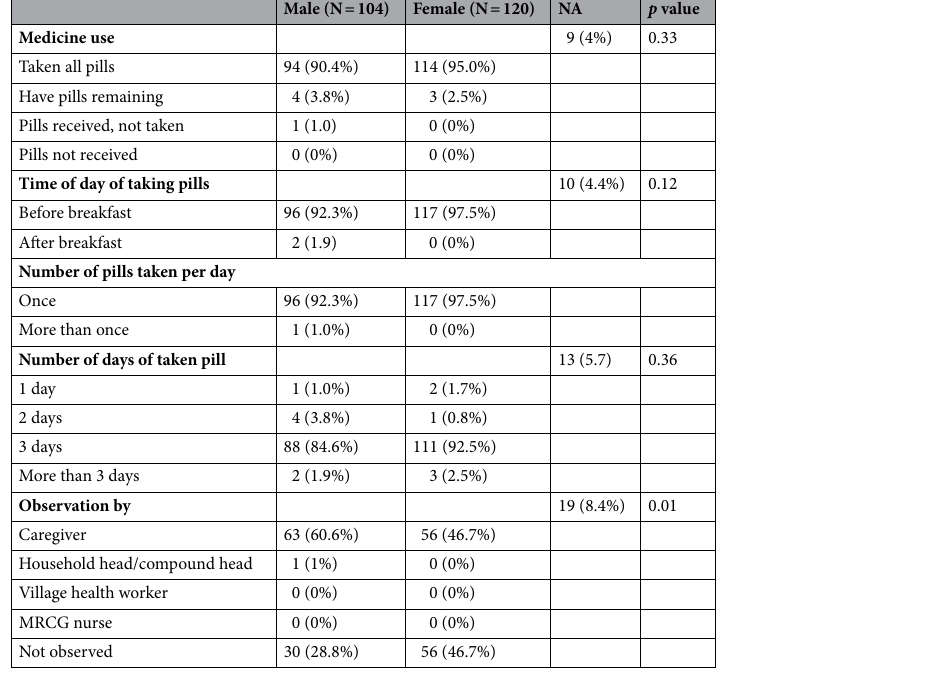
Table 3. Self-reported adherence to DP treatment (N =